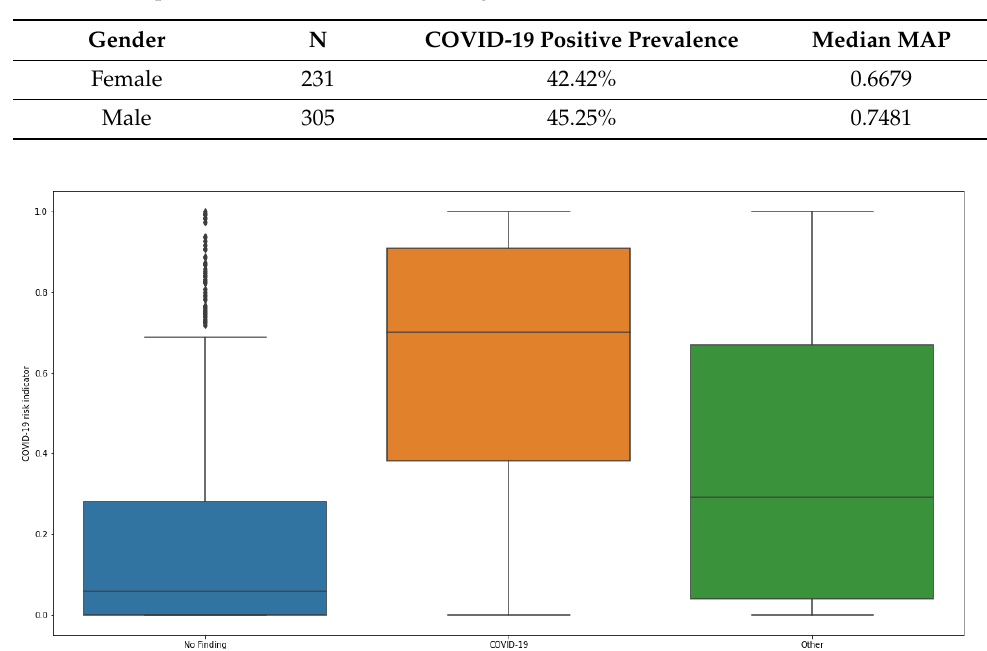
Figure 8. Distribution of the predicted COVID-19 risk indicator for cases belonging to the three clas- ses.